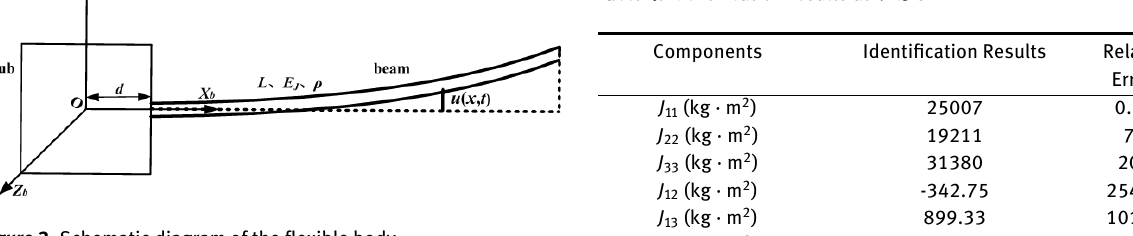
Figure 3. Schematic diagram of the flexible body